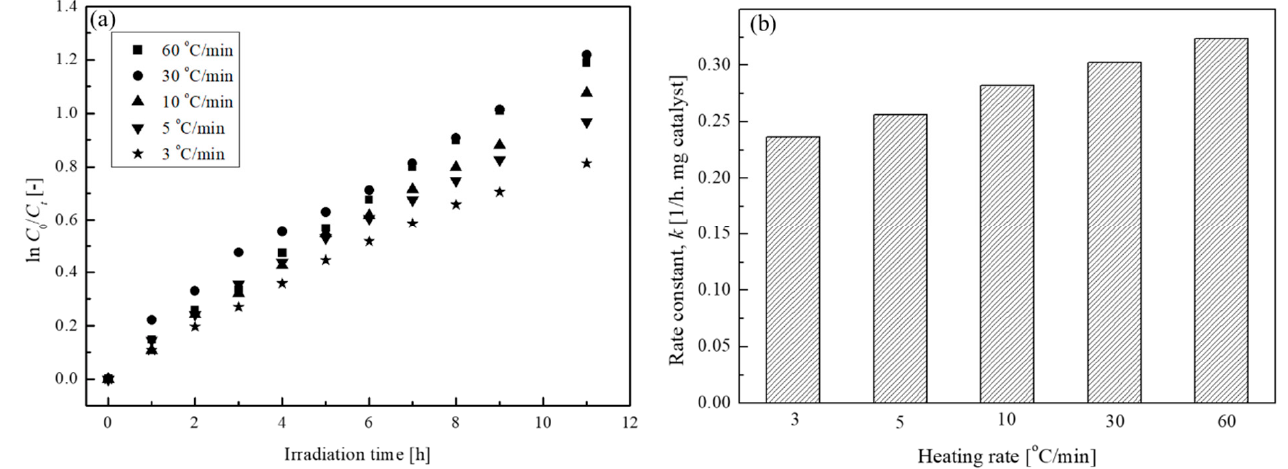
Figure 4. Photocatalytic activity of the Ag–TiO 2 nanocomposite films annealed at 600 ◦ C with different heating rates: plots of ln C 0 /C t vs. irradiation time ( a ) and rate constants ( b ).